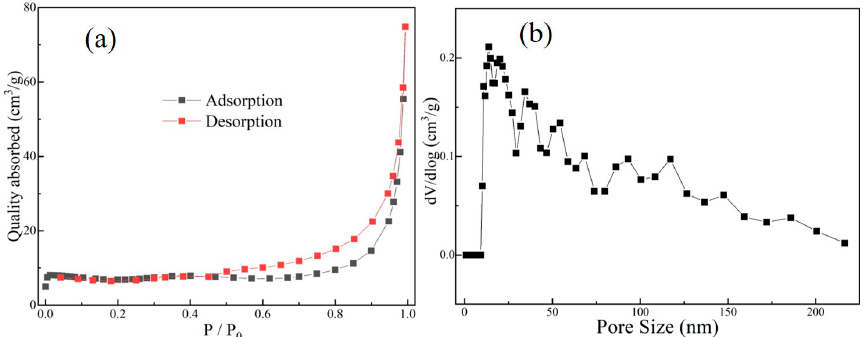
Figure 1. ( a ) The nitrogen adsorption-desorption isotherm curve and ( b ) the corresponding pore size distribution of multilayer graphene.